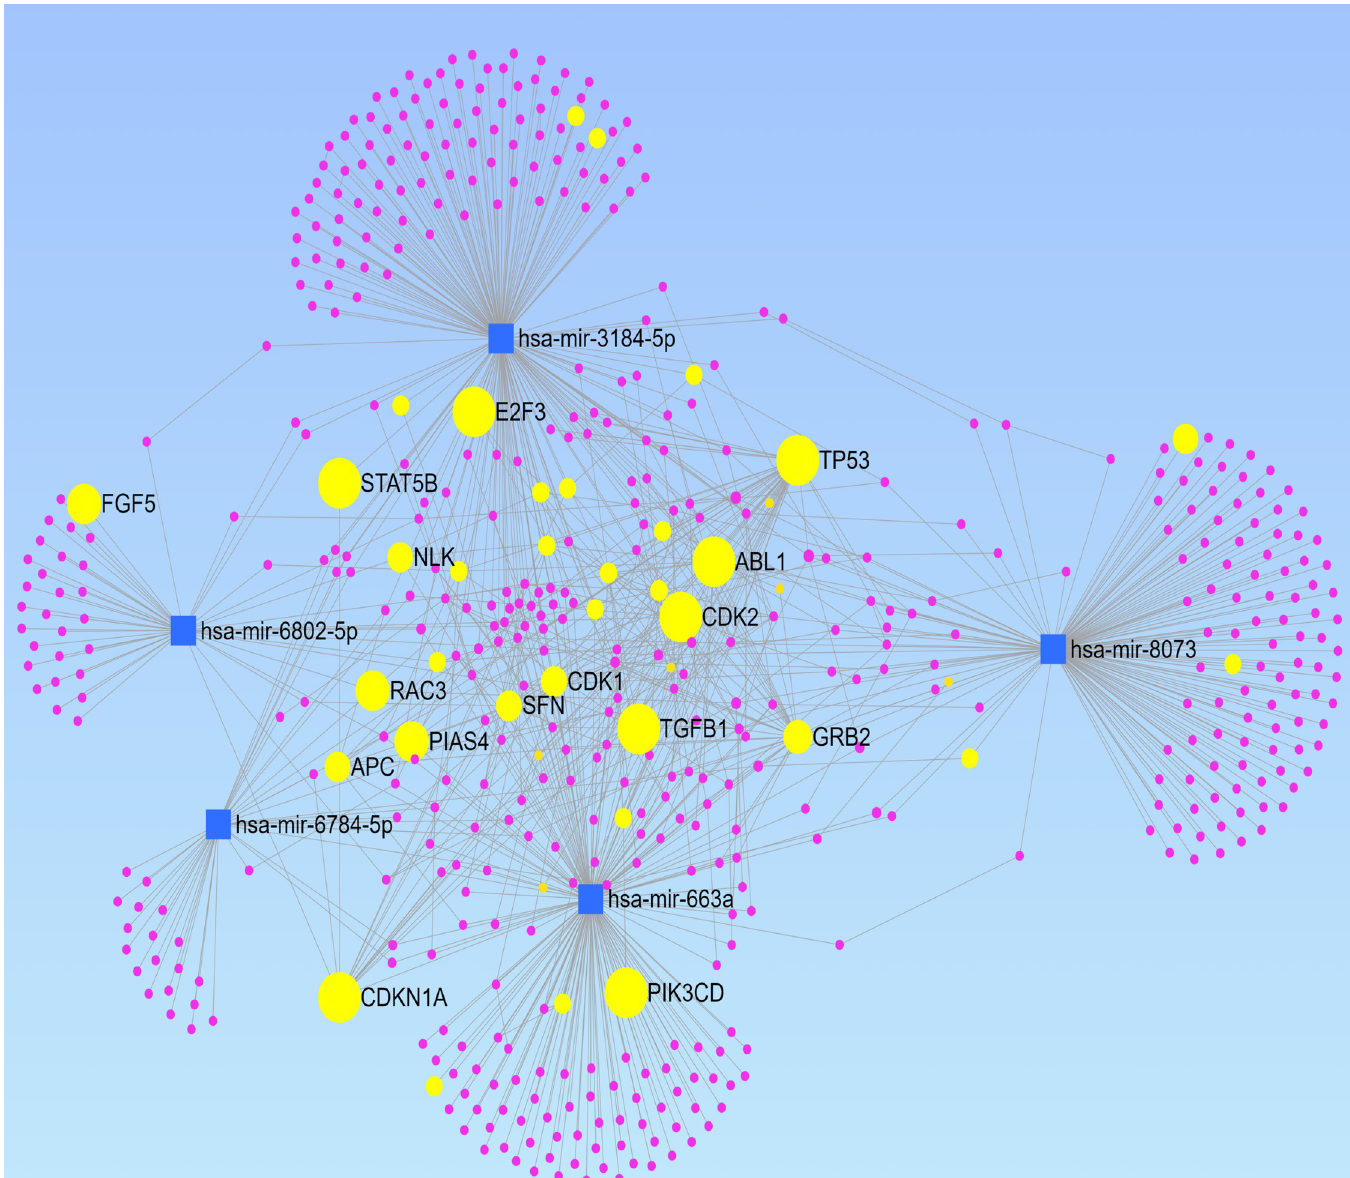
Fig 4. miRNA-mRNA interaction network for the selected 5 miRNAs. The blue squares represent the miRNAs. The purple and yellow circles represent the mRNAs. The yellow circles represent mRNAs directly associated with cancer, with the bigger yellow circles indicating that the mRNA is more associated with the selected 5 miRNAs. The edge between two nodes indicates their